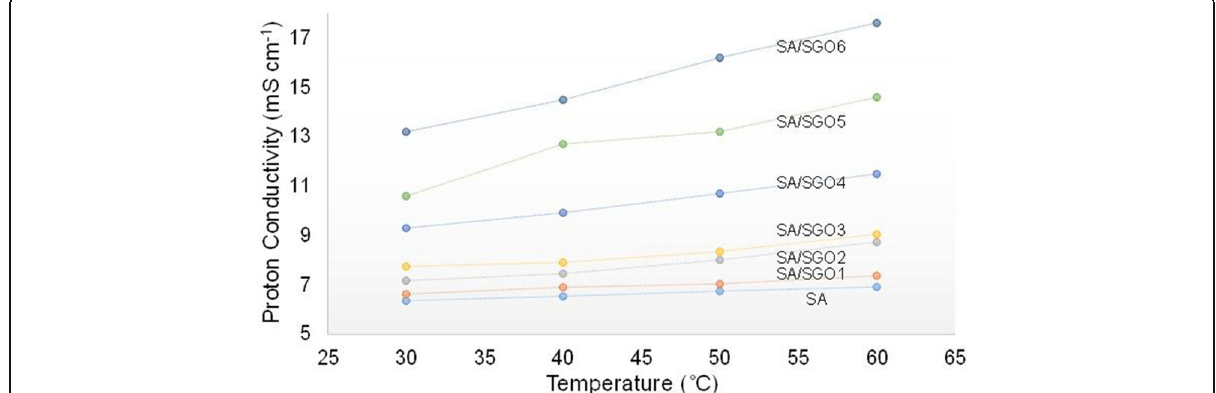
Fig. 10 Proton conductivity of SA/SGO biomembranes with various content of SGO at different temperature